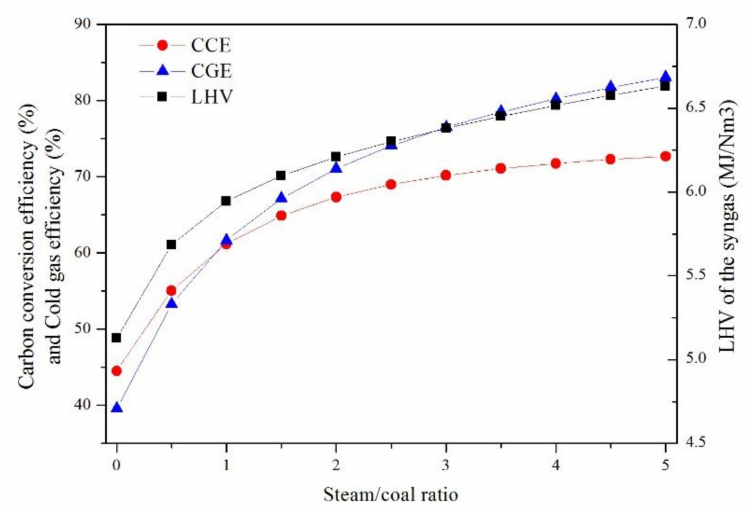
Figure 10. E ff ect of the S / C ratio on CCE, CGE, and LHV (Simulation, ER = 0.2, T = 700 ◦ C).